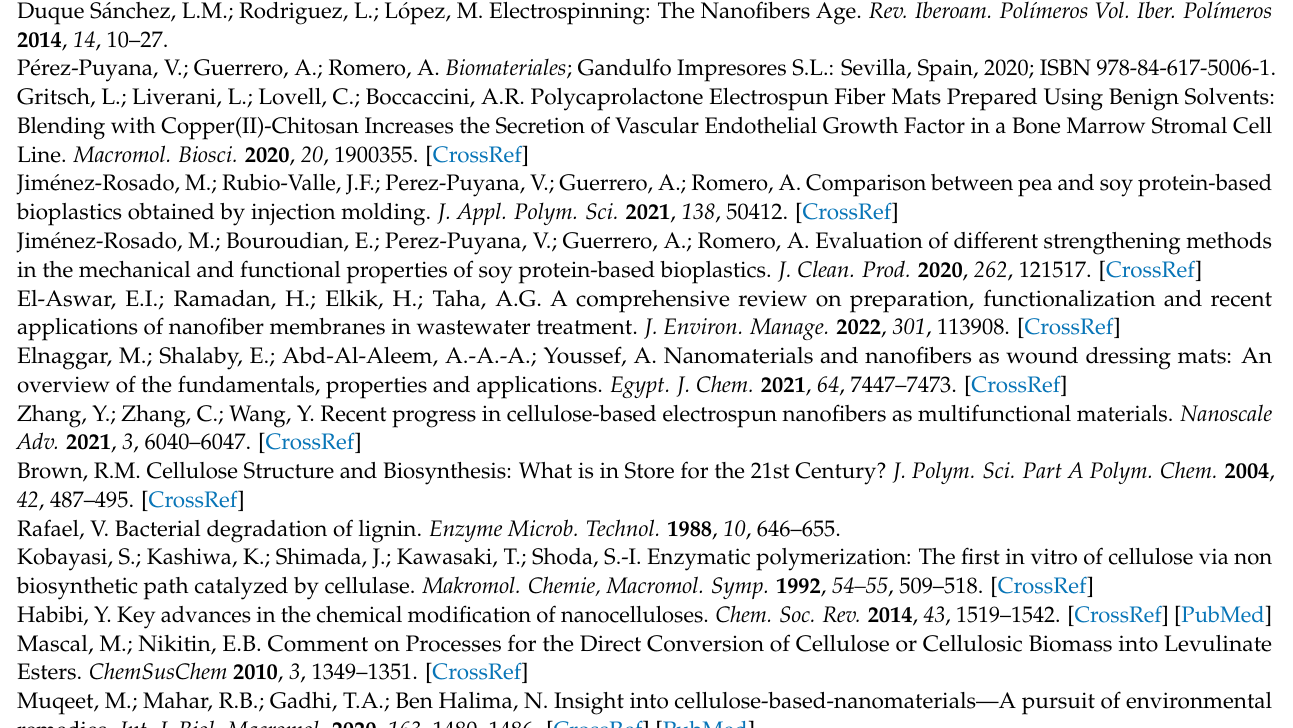
Figure S2: TGA analysis of electrospun nanostructures for systems made with: A) AC + Acetic acid/H2O, B) AC + Acetone/DMF and C) EC + acetone/DMF; Figure S3: DSC analysis of AC, AC (10 wt.%) + Acetic acid/H2O, AC (15 wt.%) + Acetone /DMF, EC and EC (5 %) +